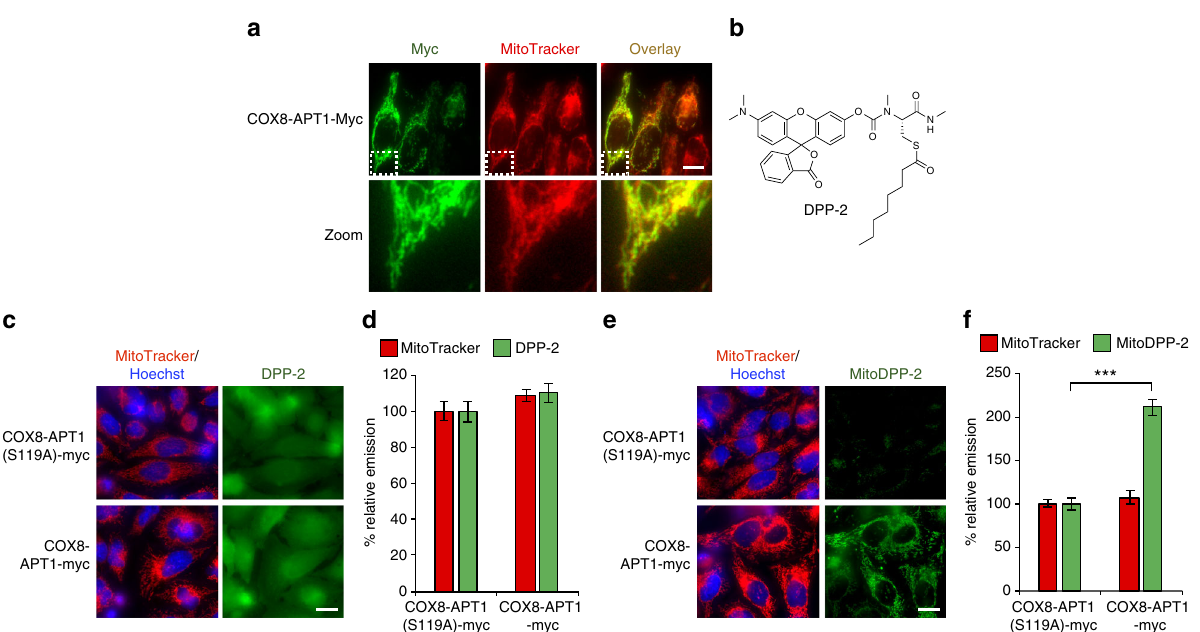
Fig. 4 Overexpression of a mitochondrial-targeted APT selectively effects mitoDPP-2. a Immunostaining of HeLa cells overexpressing APT1 fused to a COX8 mitochondrial targeting sequence (COX8-APT1-myc) shows the fusion protein localized to mitochondria. b Structure of DPP-2, a previously reported, non-targeted cysteine deacylase probe. c HeLa cells transfected with COX8-APT1-myc or a catalytically inactive version, COX8-APT1(S119A)- myc, for 30 h, then loaded with 1 µ M DPP-2 for 10 min, and analyzed by fl uorescence microscopy. d Quanti fi cation of experiment described in ( c ) reveals that overexpressing a mitochondrial-targeted APT has no effect on the cytosolic APT signal as measured by DPP-2. e HeLa cells transfected with COX8- APT1-myc or a catalytically inactive version, COX8-APT1(S119A)-myc, for 30 h, then loaded with 500 nM mitoDPP-2 for 10 min, and analyzed by fl uorescence microscopy. f Quanti fi cation of experiment described in ( e ) reveals that overexpressing a mitochondrial-targeted APT causes a signi fi cant enhancement on the mitochondrial APT signal as measured by mitoDPP-2. For all imaging, 20 µ m scale bar shown. For plots, statistical analyses performed with a two-tailed Student ′ s t -test with unequal variance, *** P value < 5 × 10 − 7 ; n = 8 images from two biological replicates, error bars are ±